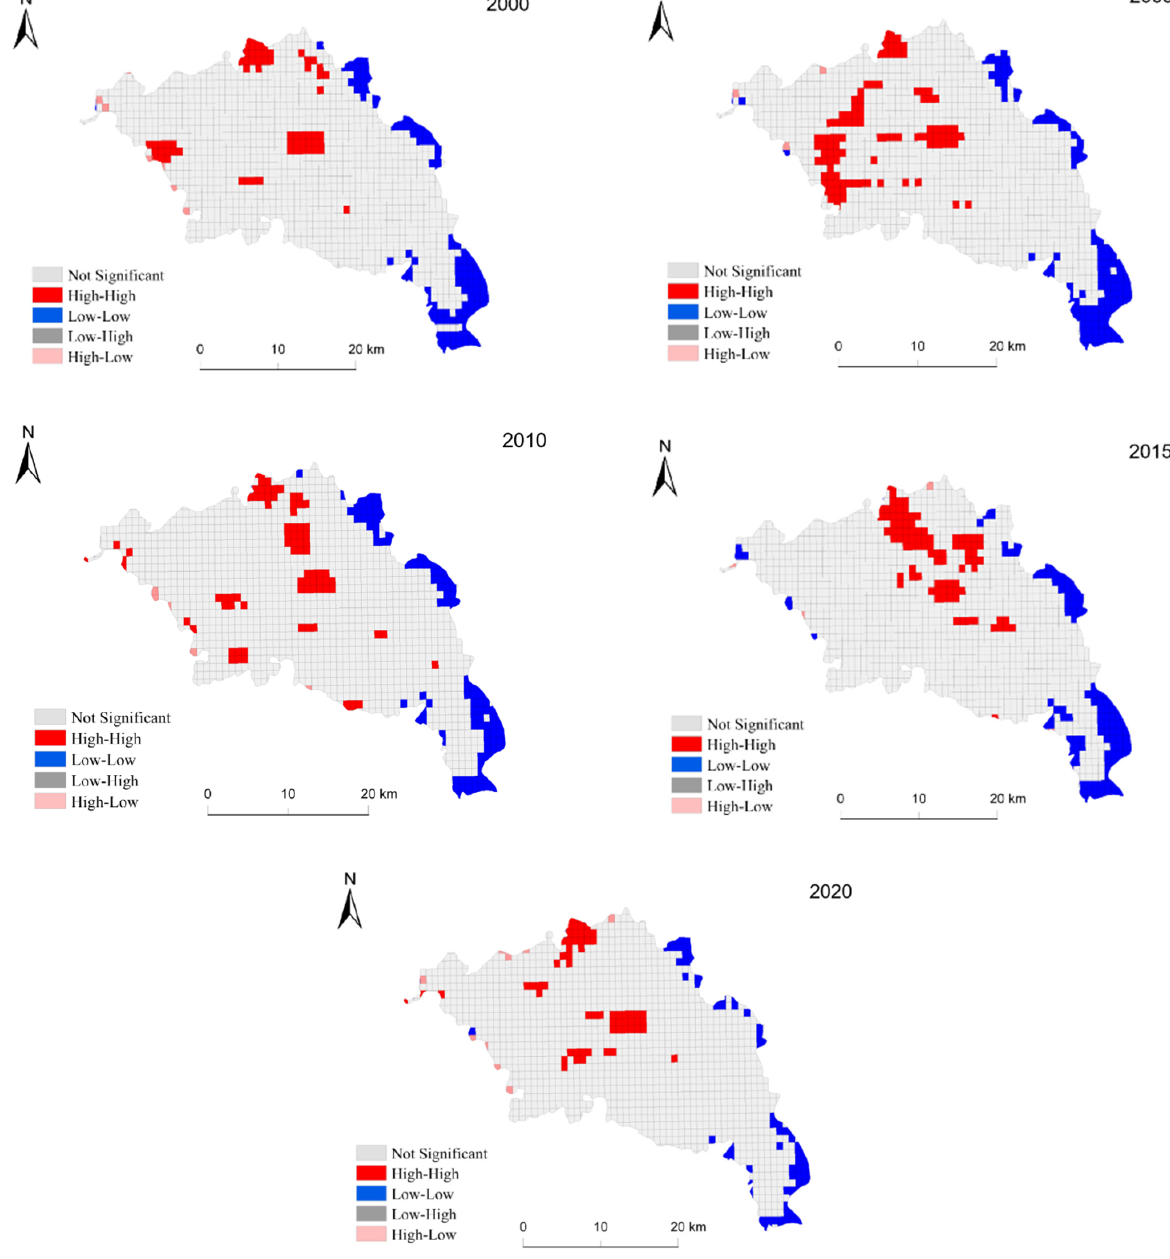
Figure 10. Local indicators of spatial autocorrelation (LISA) map of the local spatial auto-orrelation of ecological risks in Zhangjiachuan County from 2000 to 2020.